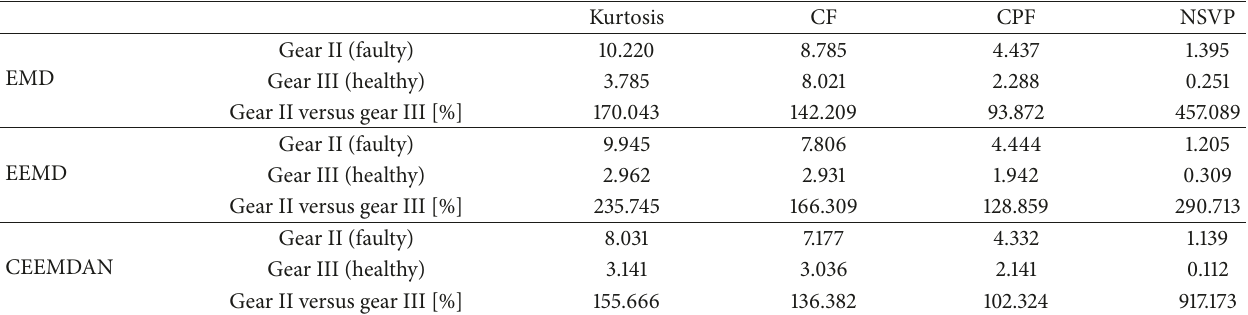
Table 4: CIs for the vibration signal of Case 1, with localized fault in gear